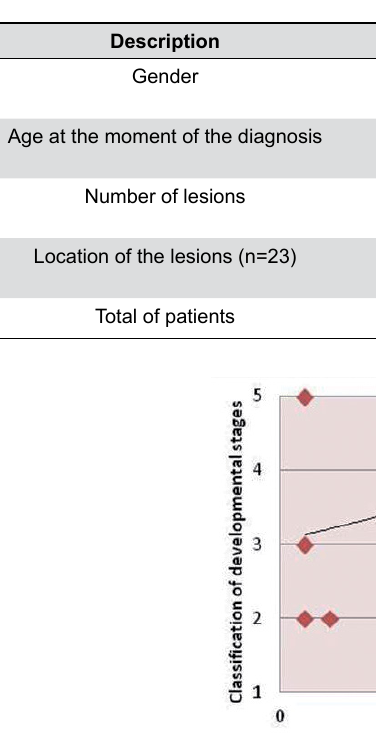
Table 1- Clinical data of the patients